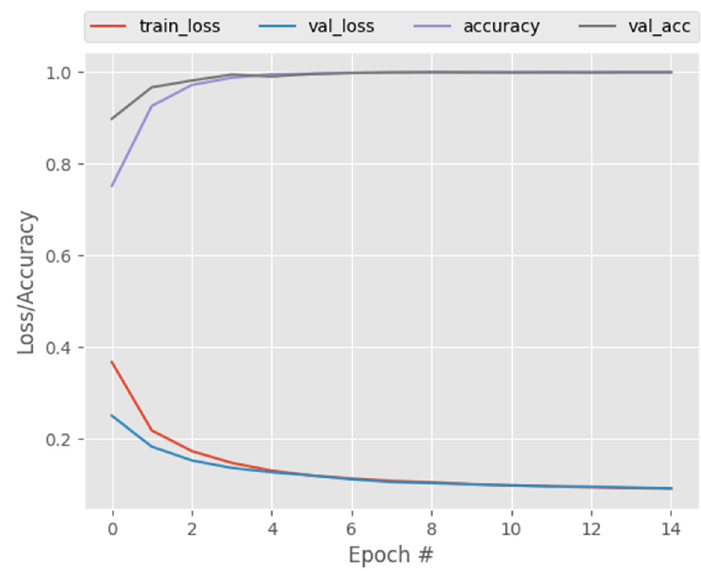
Figure 4. CapsNetCovid training and validation performance.